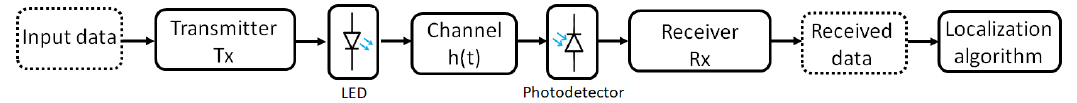
Figure 2. Proposed model for placing the LEDs and photodetectors.